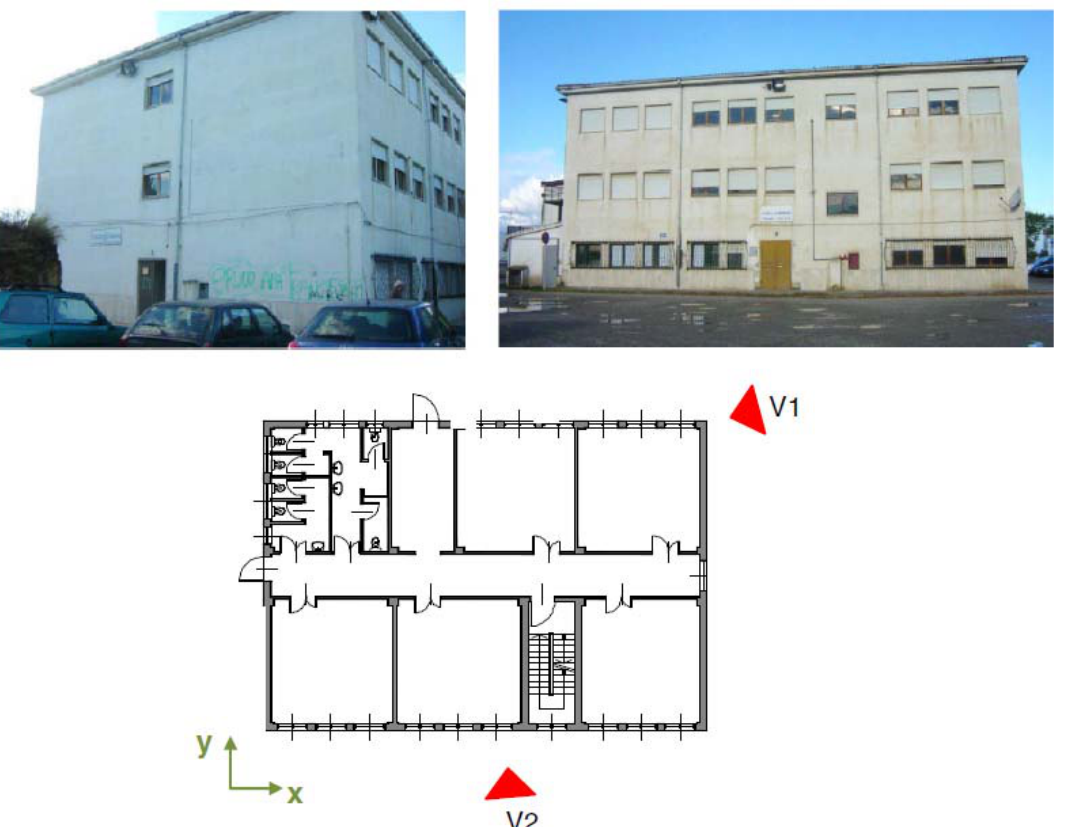
Figure 11. General views of the benchmark building and architectural plan of the floor type [19].